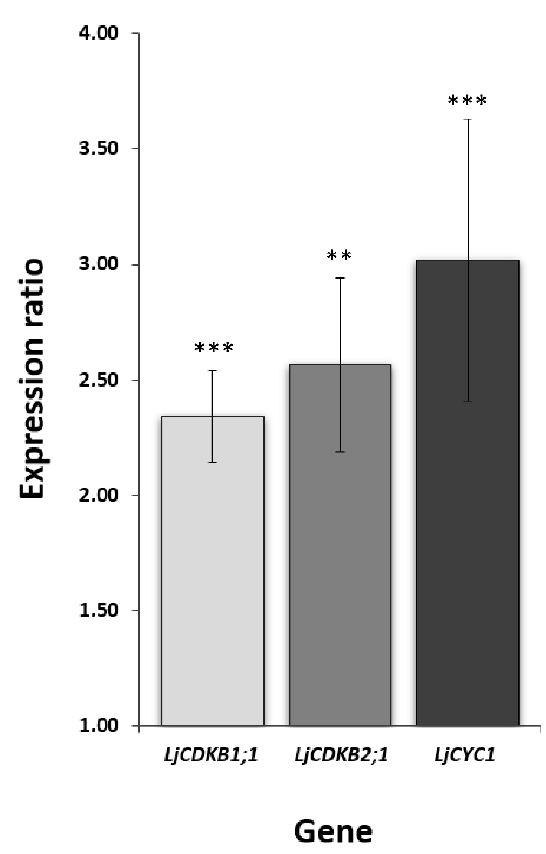
Figure 7. Relative expression level of G2-M phase cell cycle markers. The expression values for root nodules at 54 dpi were set as unity for each tested gene and the expression level in the nodules formed at 20 dpi was proportionally converted. Mean values ( ± SE) were derived from three biological replicates, for which three individual qPCR reactions were performed ( n = 9). Asterisks above the bars represent a statistically significant difference in comparison to expression values in the nodules formed 54 dpi, at the level p < 0.01 (**) or p < 0.001 (***).